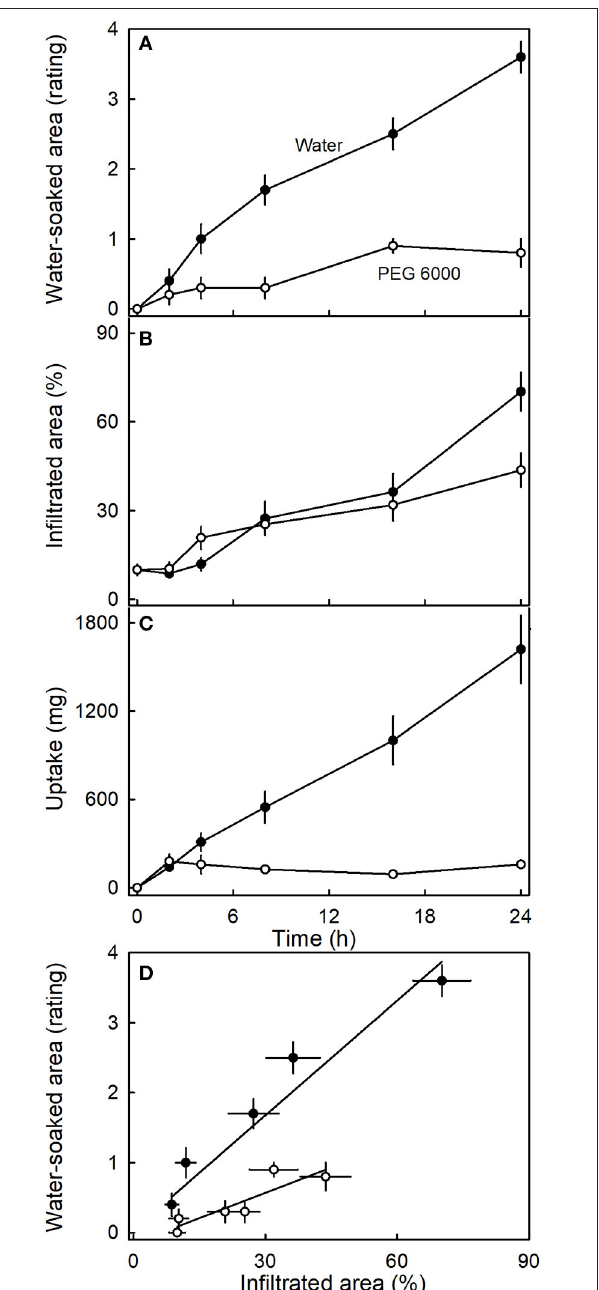
FIGURE 9 | Time course of (A) change in water-soaked area, (B) change in the area infiltrated by acridine orange, and (C) water uptake of strawberries incubated in deionized water or in isotonic polyethylene glycol 6000 (PEG 6000). (D) Relationship between the water-soaked area and the area infiltrated by acridine orange. Acridine orange penetrates the strawberry fruit skin via microcracks in the cuticle. Water soaking was indexed using a 5-point rating scale: score 0, no water soaking; score 1, < 10% of the surface area water-soaked; score 2, 10–35%; score 3, 35–60%; score 4 > 60%. Anthocyanin leakage from flesh disks increased with time and was higher in the presence of citric and malic acid, than in the control (deionized water) ( Figure 10A ). The amounts of